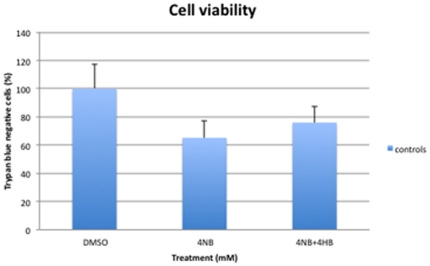
Quantitation of cell viability by trypan blue staining in control skin fibroblasts (n = 5) after co-treatment with 4 mM 4-NB+2 mM 4-HB.The values are expressed as percentage of the control skin fibroblasts after 4 mM DMSO.